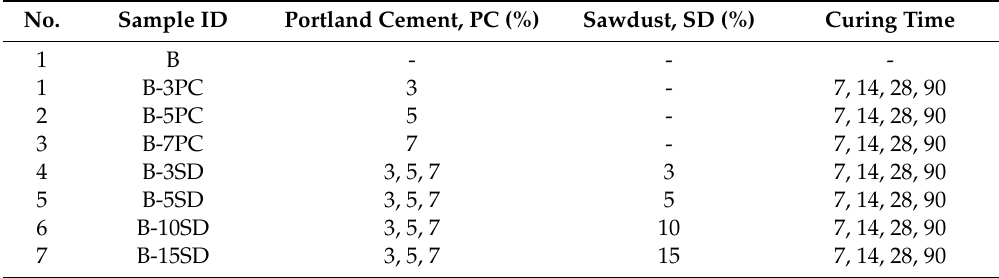
Table 3. Testing plan and mixtures.